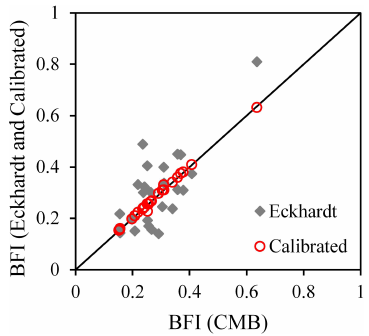
Figure 1. Comparison of BFI of the Eckhardt and conductivity mass balance (CMB) methods before and after